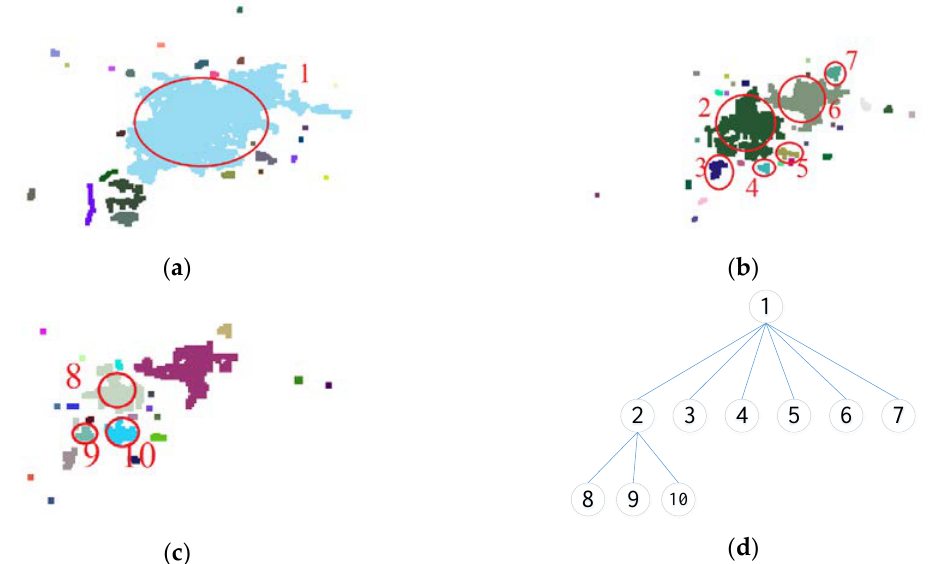
Figure 5. The tree construction of connected components: ( a ) the first layer of connectivity analysis results, ( b ) the second layer of connectivity, ( c ) the third layer of connectivity and ( d ) the constructed tree structure.